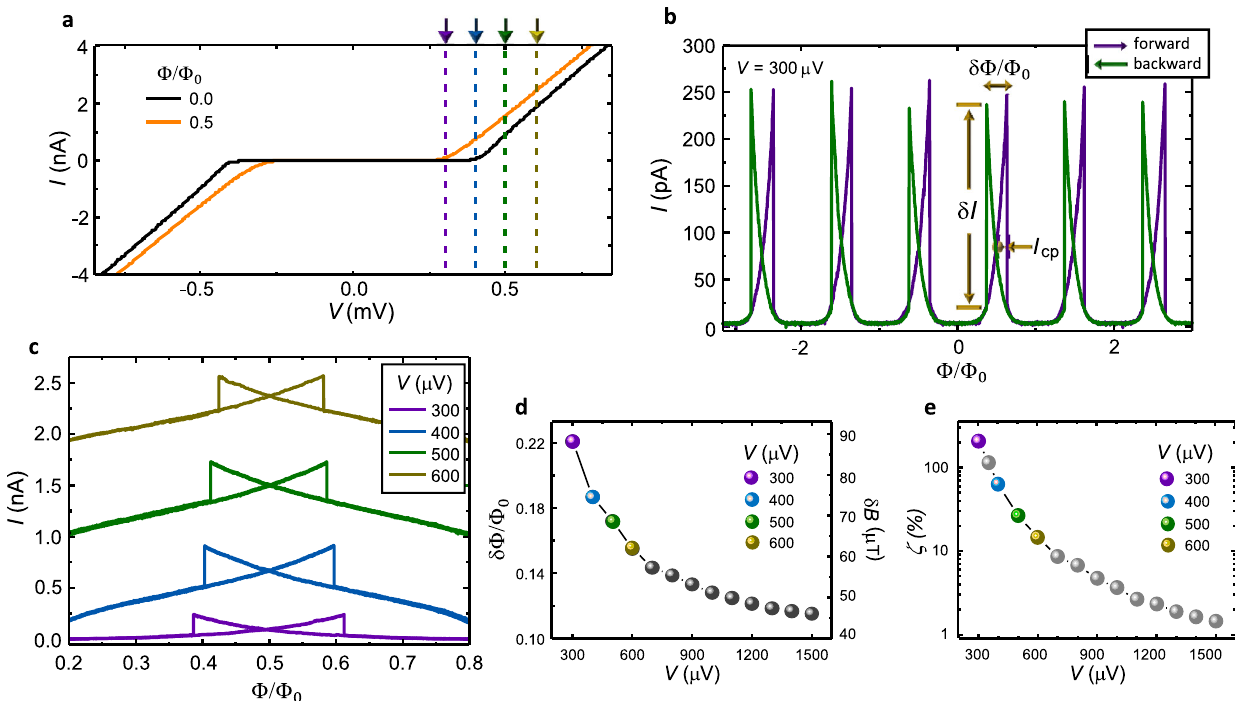
Fig. 2 Phase-slip memory magneto-electric response. a Current vs voltage characteristics acquired at Φ = 0 (black trace) and Φ = Φ 0 /2 (orange trace). The magnetic fl ux modulates Δ w and, therefore, the I − V tunnel characteristics. b I ( Φ ) of a typical memory cell biased at V = 300 μ V. The purple and green arrows indicate the magnetic fl ux sweep directions. The width of the hysteretic loop ( δ Φ ), the current drop ( δ I ), and the current at the hysteresis crossing point ( I cp = I ( Φ 0 /2)), are also indicated. c Evolution of I ( Φ ) acquired for selected values of V , as indicated by the colored arrows in a . I cp increases by rising V . d Dependence of the hysteresis width ( δ Φ ) on V . δ Φ monotonically drops by increasing V . e Relative variation of the tunneling current ( ζ = δ I / I V . All these measurements were taken at T = 25 cp ) vs